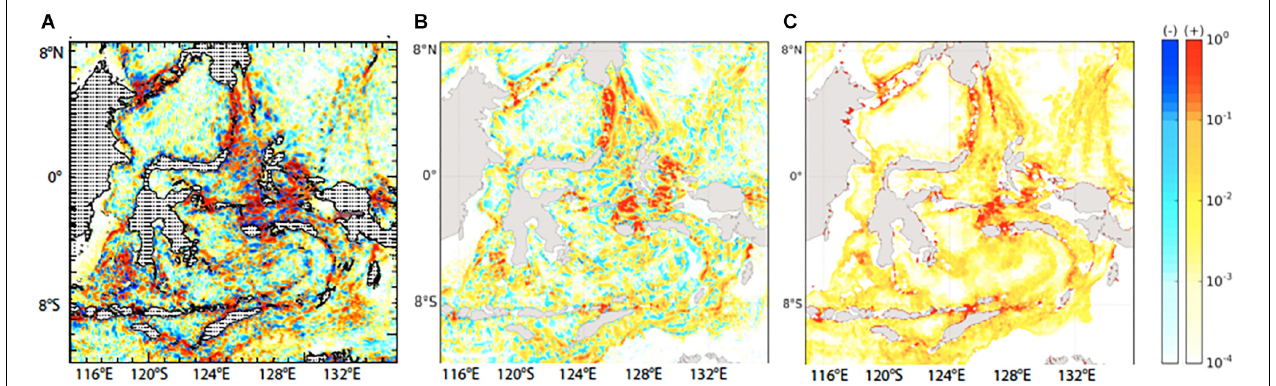
FIGURE 11 | Generation regions of internal tides, which correspond to the energy transfer from barotropic to baroclinic tides (Logarithmic scale, Wm − 2 ), from (A) MITgcm (1/100 ◦ ), (Figure from Nagai and Hibiya, 2015), (B) INDESO NEMO and (C) FES2014 (Figure from Nugroho, 2017. Permission obtained from author). Red colors are likely generation areas whereas blue might be an artifact of the model and/or the numerical calculation due to possible non-linear interaction between the surface and internal